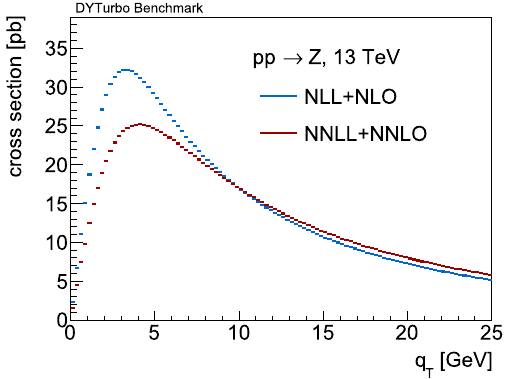
Fig. 10 Example of predictions at NLL + NLO and NNLL + NNLO accuracy for Z -boson production at